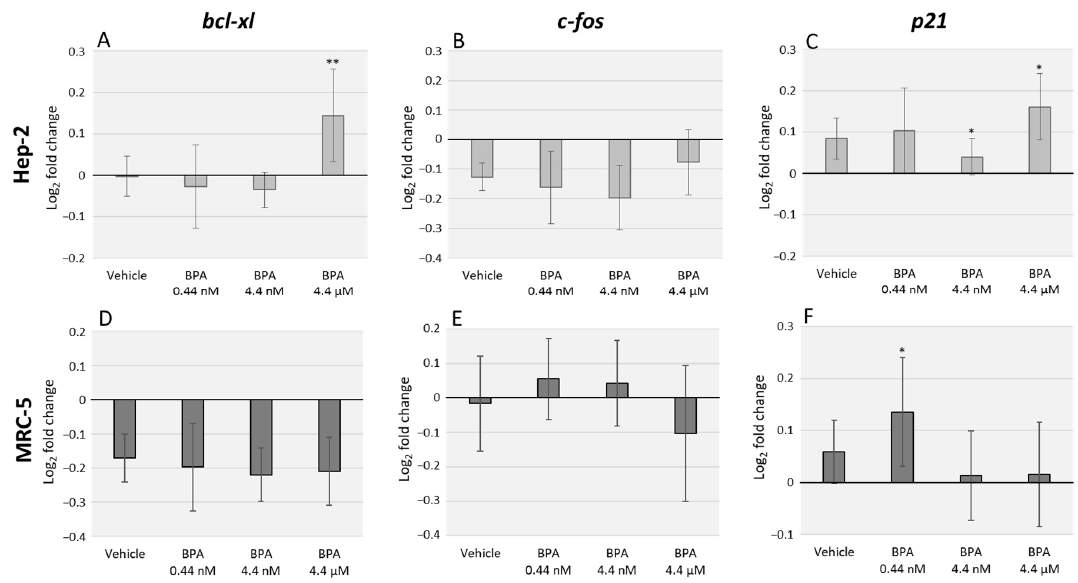
Figure 1. Quantitative real-time PCR (qRT-PCR) analysis of Hep-2 ( A – C ) and MRC-5 ( D – F ) cell lines after exposure to three different concentrations of Bisphenol A (BPA). The data represent the relative expression of the genes: bcl-xl ( A , D ), c-fos ( B , E ), and p21 ( C , F ). GAPDH and β -actin were used for normalization. The error bars represent the standard deviation between two independent treatments and three qRT-PCR replicates. Significant statistical values, which were compared with the vehicle (EtOH) and calculated with Student’s t -test, are illustrated as: * p < 0.05 and ** p < 0.01.